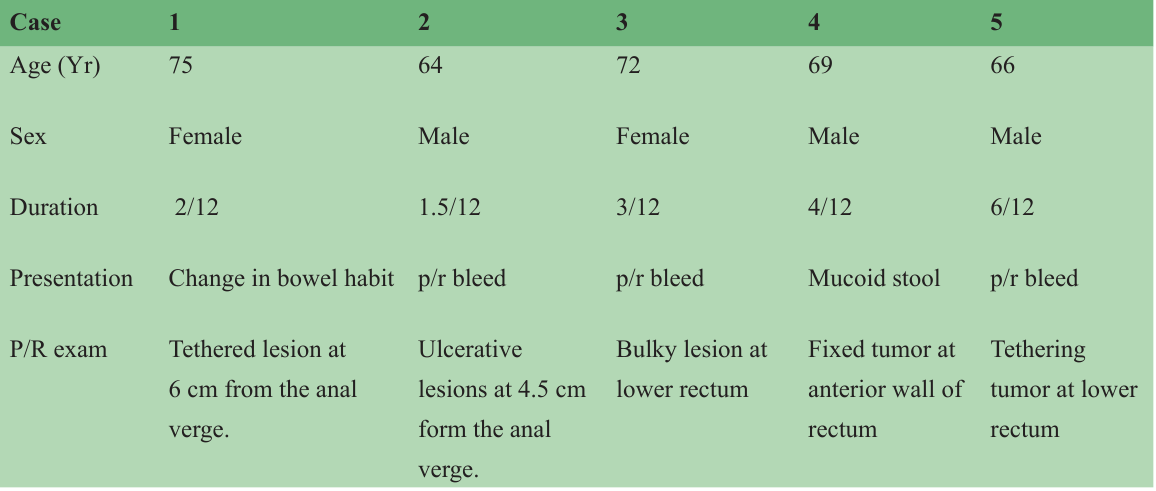
Table 1: Pre-treatment data of the patients of APER.